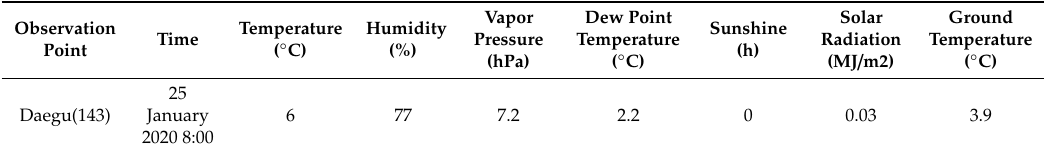
Table 1. Training data sample.